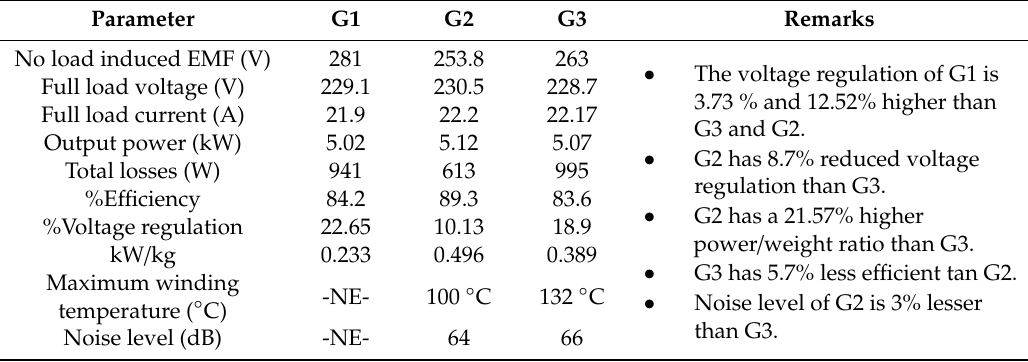
Figure 16. Acoustic pressure level for ( a ) G2 and ( b ) G3. Table 5. Overall performance comparison of G1, G2, and G3 topologies.